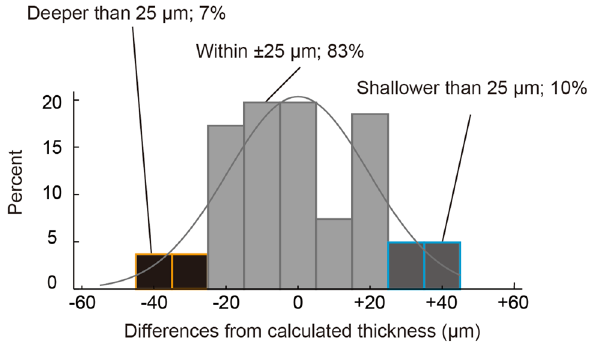
Figure 3. Cutting predictability of the nomogram. This nomogram has estimated the post-cut central graft thickness within 25 μm with a 83% probability. It poses an 7% risk of cutting 25 μm deeper than that predicted. The solid line represents a normal